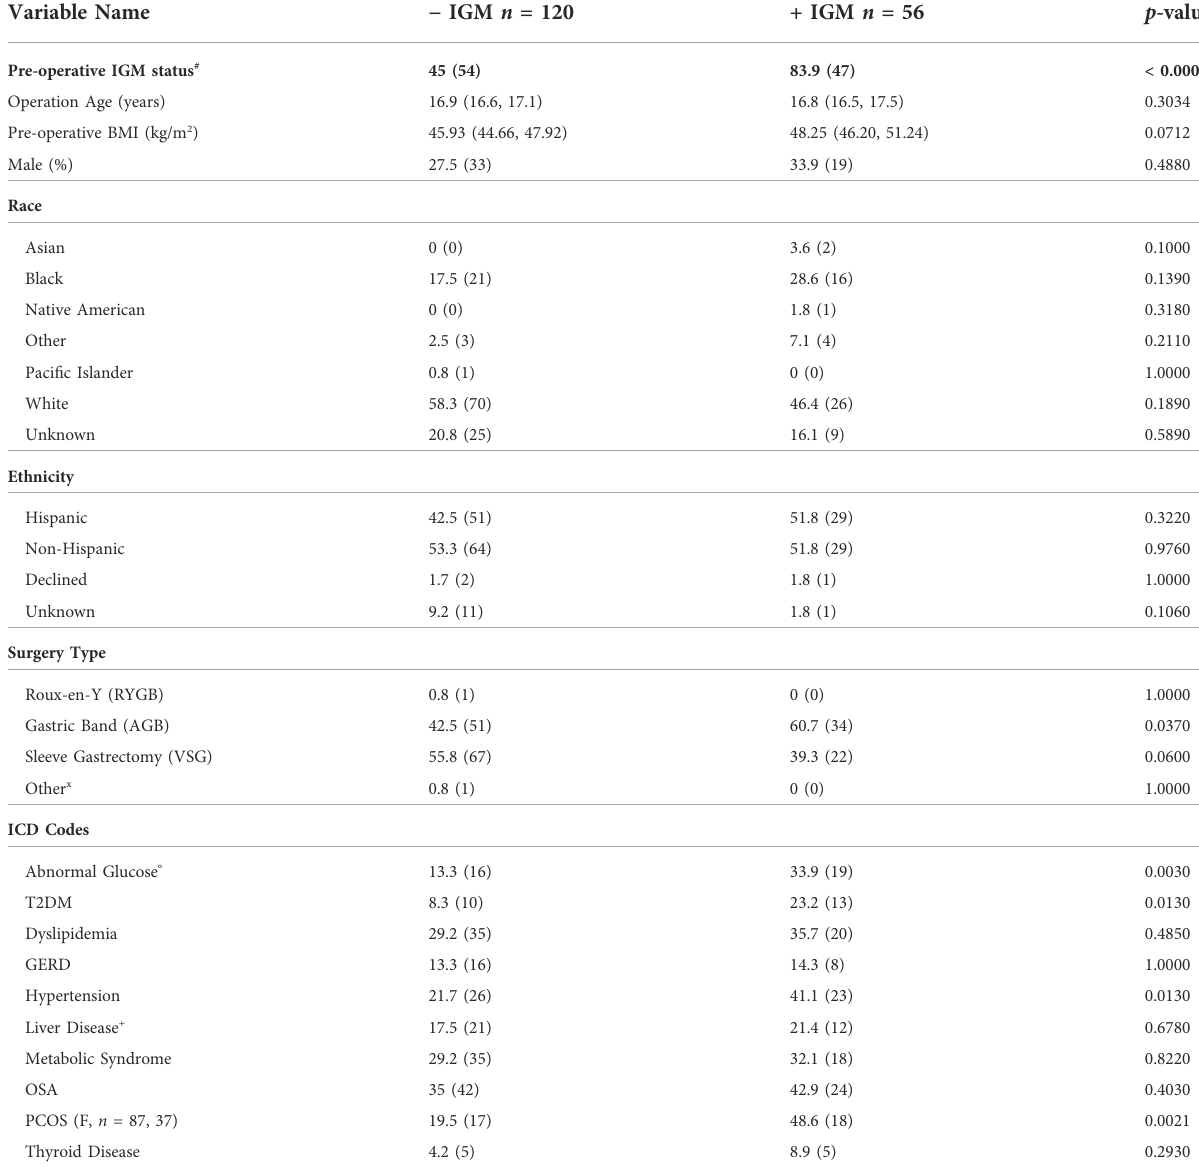
TABLE 2Pre-operative demographiccomparisons by binary post-operativeoutcome at12 months.For continuousvariables, medianswiththeir 95% CI are shown. Categorical variables are shown as a percentage and count. Signi fi cant p -values for Mann-Whitney-U tests after Bonferroni correction are in bold ( p <